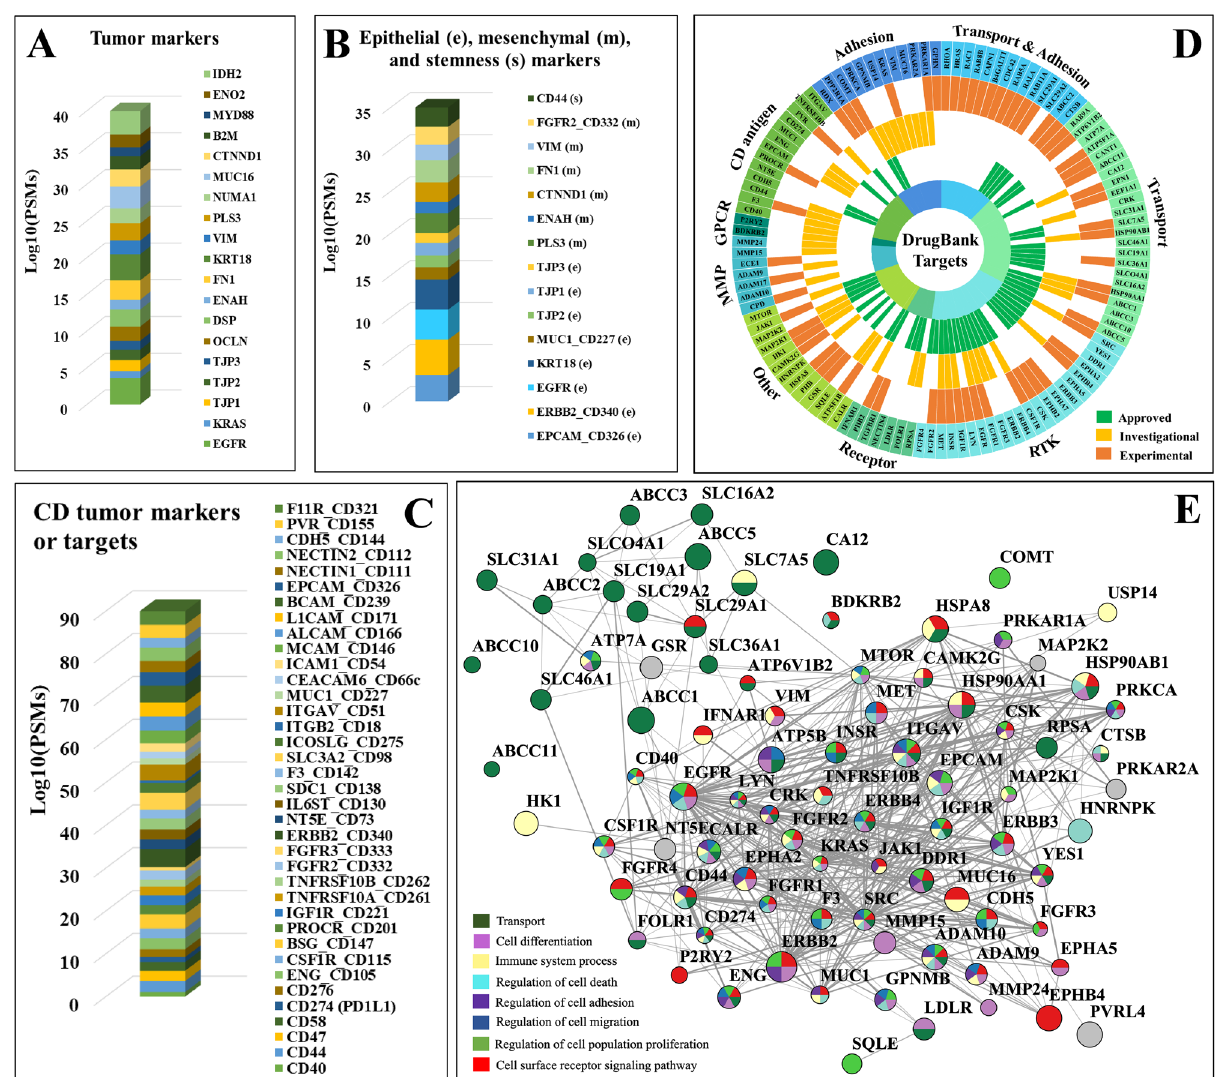
Figure 8. Cancer markers and drug targets detected in the SKBR3 cell-membrane proteome. ( A ) Tumor markers. ( B ) Epithelial (e), mesenchymal (m), and stemness (s) cancer markers. ( C ) CD Tumor markers and drug targets. ( D ) Sunburst chart representing receptors by functional categories identified in DrugBank as potential cancer therapeutic drug targets based on approved (green), investigational (yellow), and experimental (orange) status levels. ( E ) PPI network of the approved and investigational cancer drug targets. Note: Node size is proportional to the log10(SC) and edge thickness reflects the STRING interaction